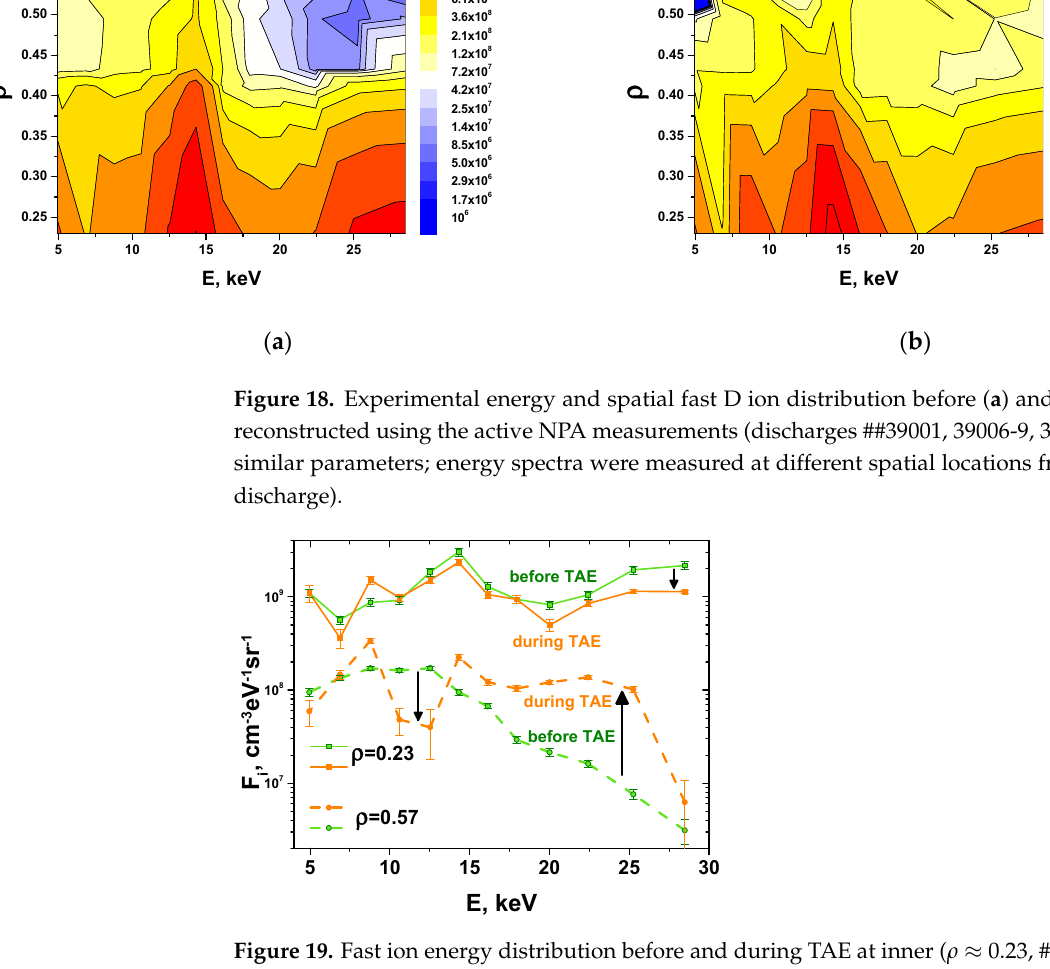
Figure 19. Fast ion energy distribution before and during TAE at inner ( ρ ≈ 0.23, #39002) and outer ( ρ ≈ 0.57, #39007) spatial points, observed by the NPA. Arrows demonstrate direction of change in the fast ion concentration at TAE excitation.